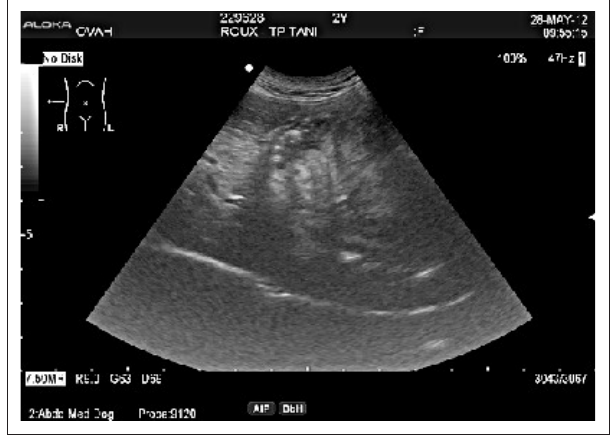
FIGURE 2: Abdominal ultrasound – Sagittal view of stomach, shows a petal appearance and apparent layering of the stomach wall.